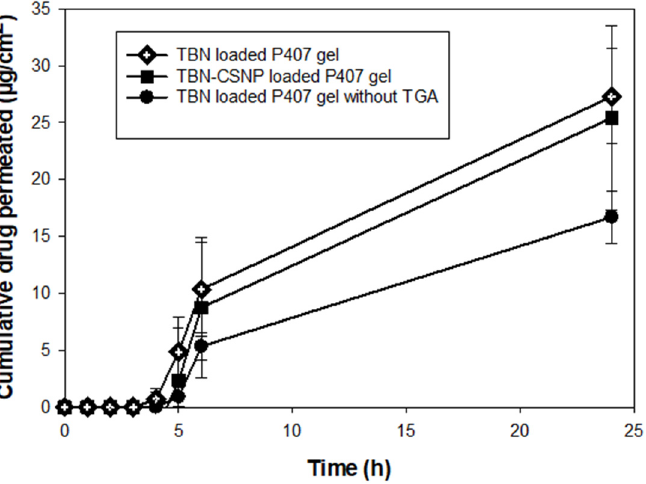
Figure 9. Ex vivo permeation across nail from TBN-CSNP loaded gel, TBN loaded P407 gel and TBN loaded gel (without TGA). Each value represent mean ± S.D ( n = 3).